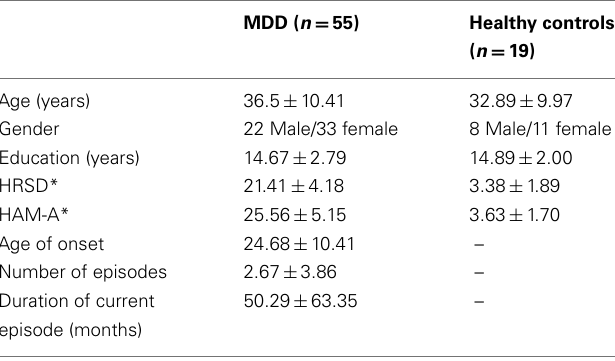
Table 1 | Demographic and clinical characteristics for the study